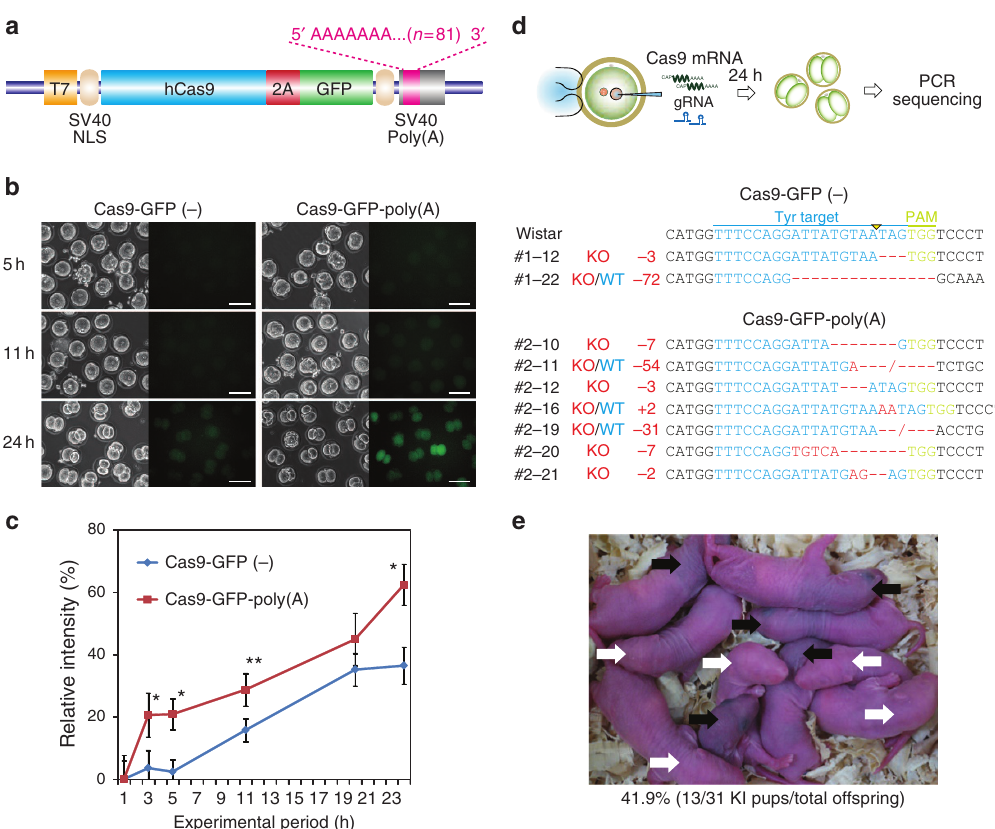
Figure 1 | Poly(A) tail elongation enhances genome-editing efficiency in zygotes. ( a ) Schematic representation of the Cas9-2A-GFP plasmid. An 81-bp poly(A) was added to the 3 0 -untranslated region (UTR) of the construct. ( b ) In vitro -transcribed Cas9 mRNA (100ng m l (cid:2) 1 ) was injected into pronuclei of rat fertilized eggs. Fluorescence microscopy images were captured after injection. ( c ) The fluorescence intensity of oocytes was estimated as relative intensity with the highest intensity of oocytes after 24-h incubation set at 100%. * P o 0.05 and ** P o 0.001 by Student’s t -test. Error bars represents.e.m. ( d ) Co-injection of gRNA (50ng m l (cid:2) 1 ) targeting the rat tyrosinase ( Tyr ) gene with Cas9 mRNA into rat fertilized eggs resulted in NHEJ-mediated KO mutations at the targeted sites (Supplementary Fig. 1). Two-cell embryos were collected and genomic DNA was amplified by PCR to detect NHEJ-mediated KO mutations at the targeted Tyr locus. ( e ) Co-injection of ssODN (50ng m l (cid:2) 1 ) with gRNA and Cas9-poly(A) mRNA into rat fertilized eggs corrected the albino phenotype (white arrows) by HDR-mediated single nucleotide polymorphism (SNP) exchange, to produce the black-hooded phenotype (black